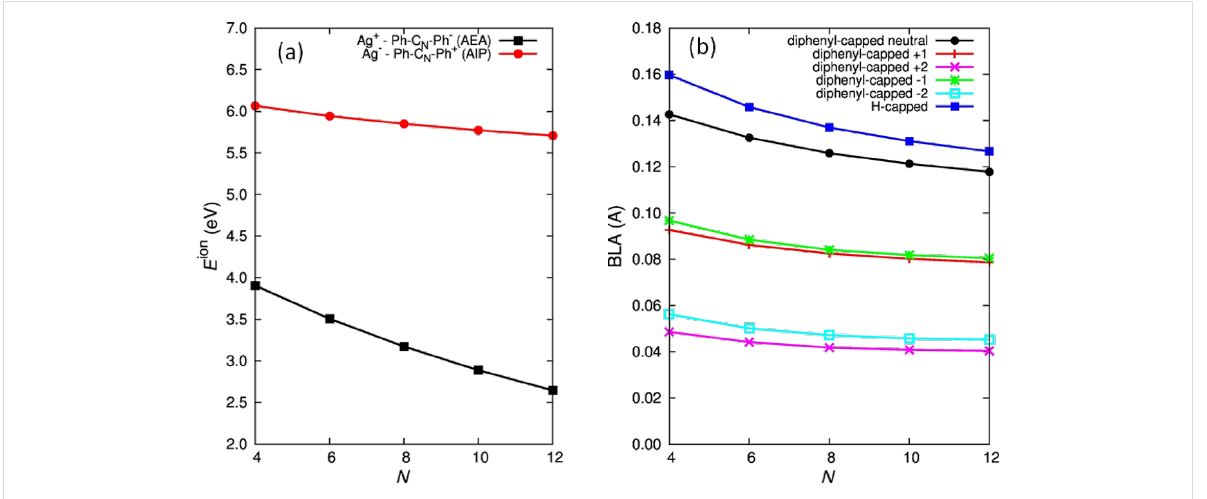
Figure 8: (a) Plot of the DFT-computed energy [39] required for the formation of the charged species ( E ion = IP(A) − |EA(B)| where IP(A) is the ioniza- tion potential of A and EA(B) is the electron affinity of B) for the two possible cases Ag + [Ph–C N –Ph] − and Ag − [Ph–C N –Ph] + of phenyl-capped polyynes of different chain lengths ( N ). The following experimental values for the work function and EA have been used in the case of Ag: IP = 4.6 eV and EA = − 1.30 eV for EA [34] (b) Modulation of the DFT-computed [39] BLA for phenyl-capped polyynes of different lengths ( N ) and charge states (0, +1, − 1). Figure adapted with permission from [39], copyright 2011 American Chemical